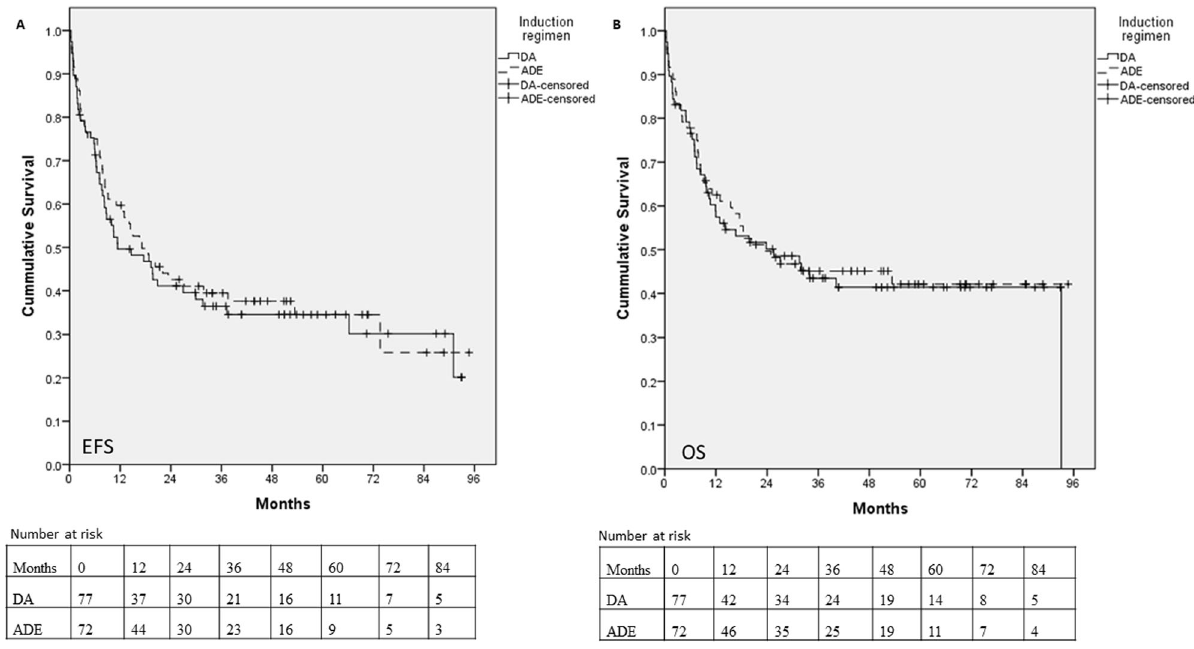
Fig. 2 Kaplan-Meier survival curves. A comparing Event Free Survival (EFS) between Daunorubicin and ARAC (DA) arm and ARAC, Daunorubicin, and Etoposide (ADE) arm ( p = 0.66), and B comparing Overall Survival (OS) between DA arm and ADE arm ( p =